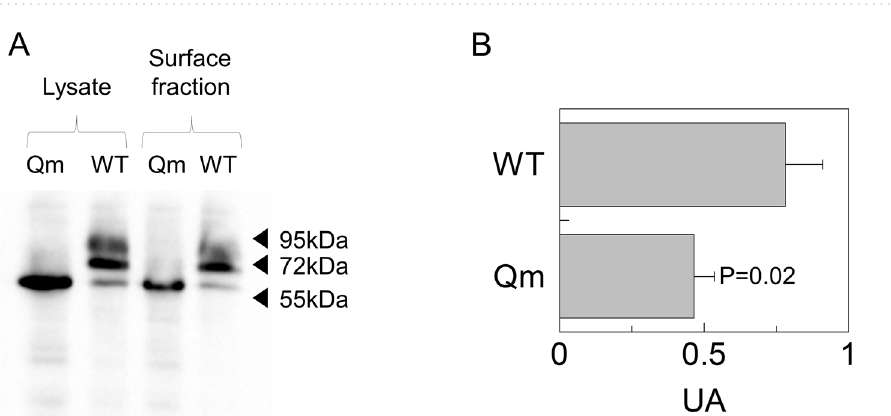
Figure 4. Cell surface biotinylation of CD98. Surface protein fractions isolated as described in material and methods were entirely loaded on SDS-PAGE for western blot analysis; total lysate used to perform membrane protein fraction isolation was shown as a control. Loading order: Qm total lysate (lane1), WT total lysate (lane 2), Qm surface fraction (lane 3) and WT surface fraction (line 4). The western blot was performed using anti-FLAG 33 . The image is representative of three independent experiments. The histogram represents mean of values obtained by scanning densitometry of immunoblots. Statistical analysis was performed for each construct measuring membrane fraction with respect to the total lysate by Student’s